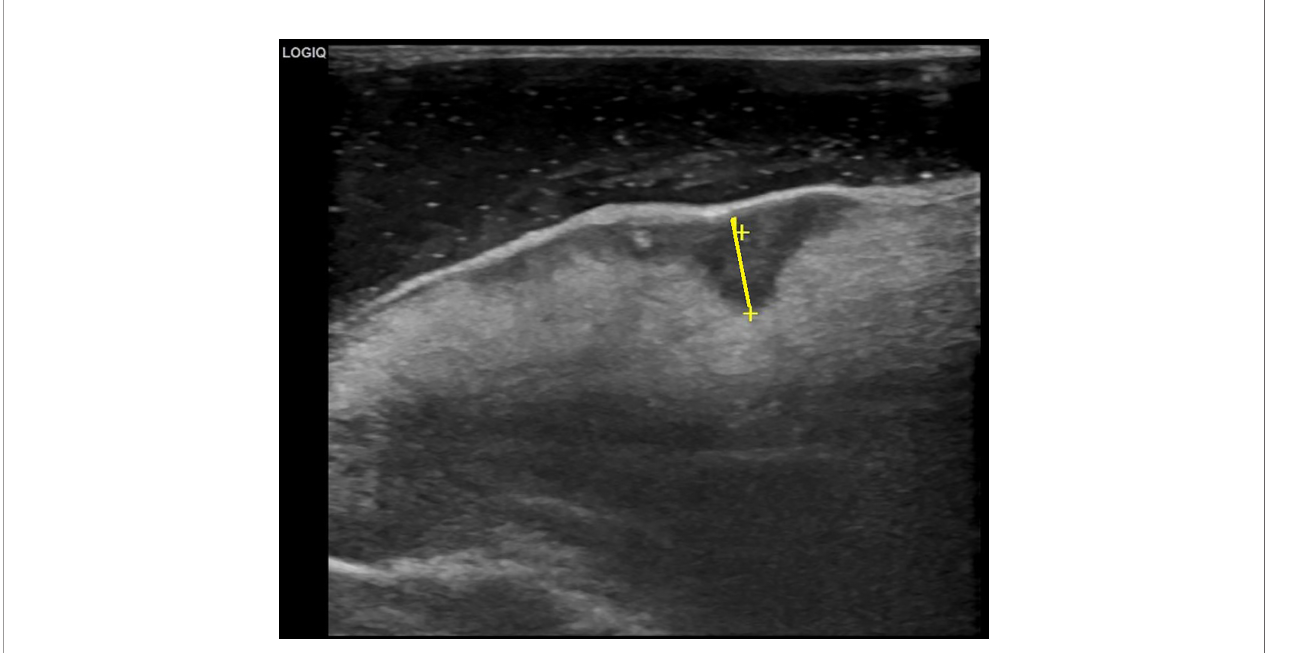
FIGURE 1 | Measurement of sonographic depth of invasion (yellow